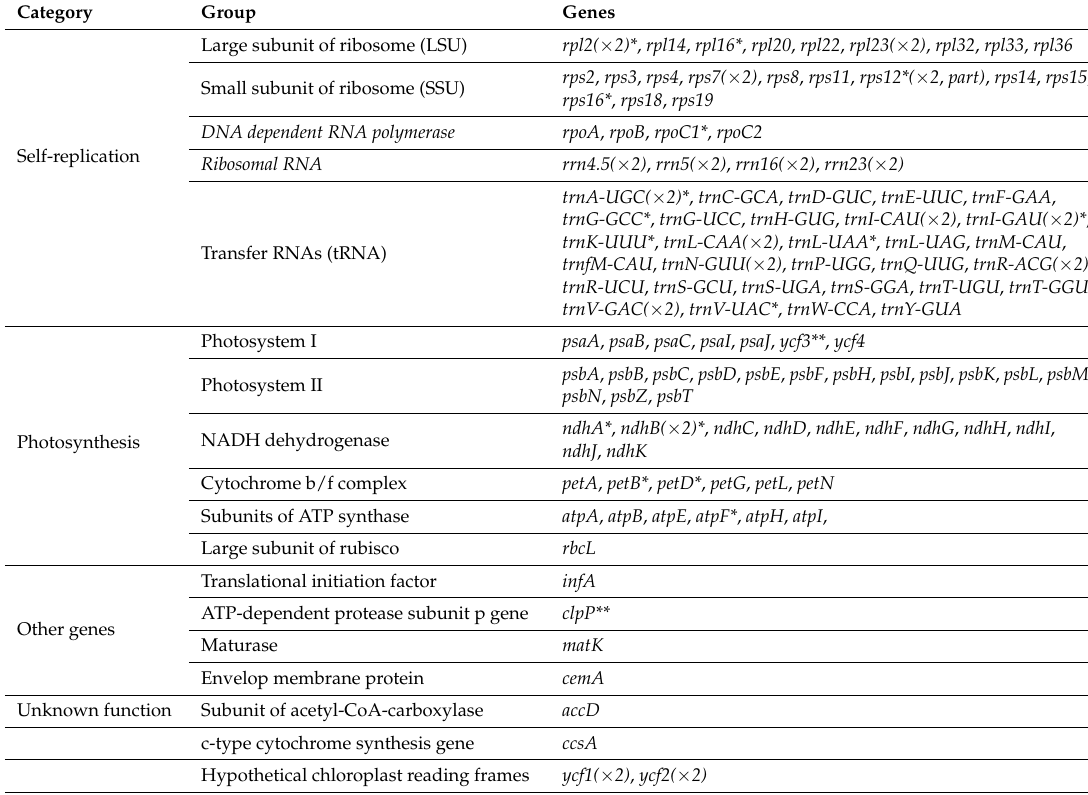
Table 1. List of genes encoded by four species of Ziziphus chloroplast